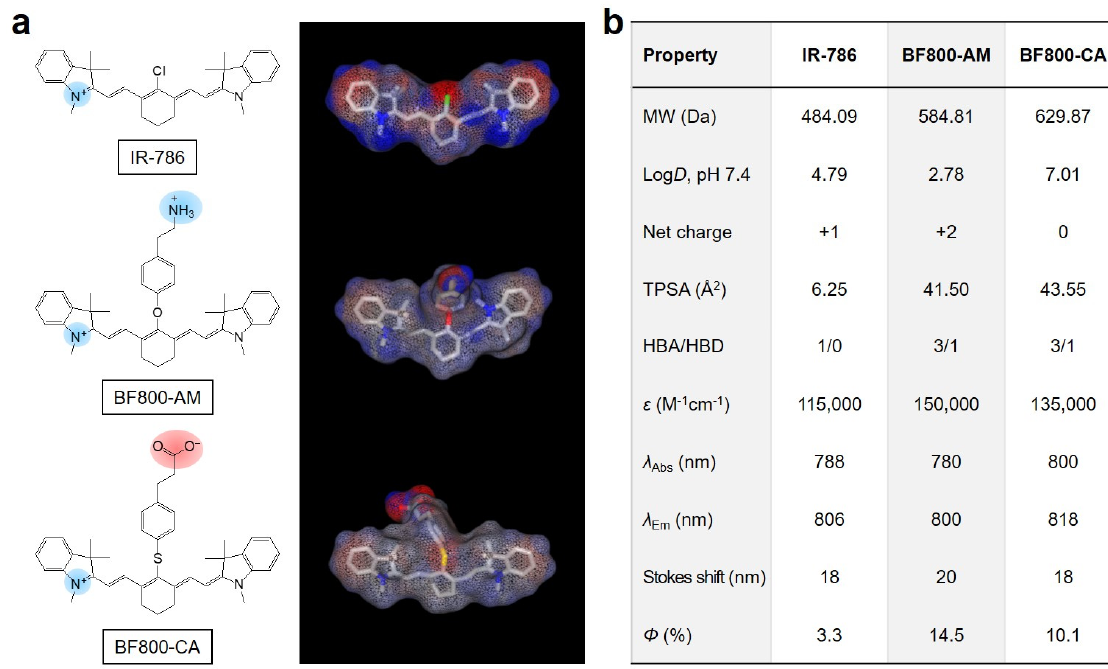
Figure 3. ( a ) Chemical structure, net surface charge, and three-dimensional (3D) modeling of the geometrical positions of IR-786, BF800-AM, and BF800-CA NIR dyes. Red, negative charge; blue, positive charge; gray, hydrophobicity. ( b ) Physicochemical and optical properties of IR-786, BF800-AM, and BF800-CA NIR dyes. In silico calculations of the distribution coefficient (log D at pH 7.4), topological polar surface area (TPSA), and hydrogen bond acceptors/donors (HBA/HBD) were performed using Marvin and JChem calculator plugins (ChemAxon).